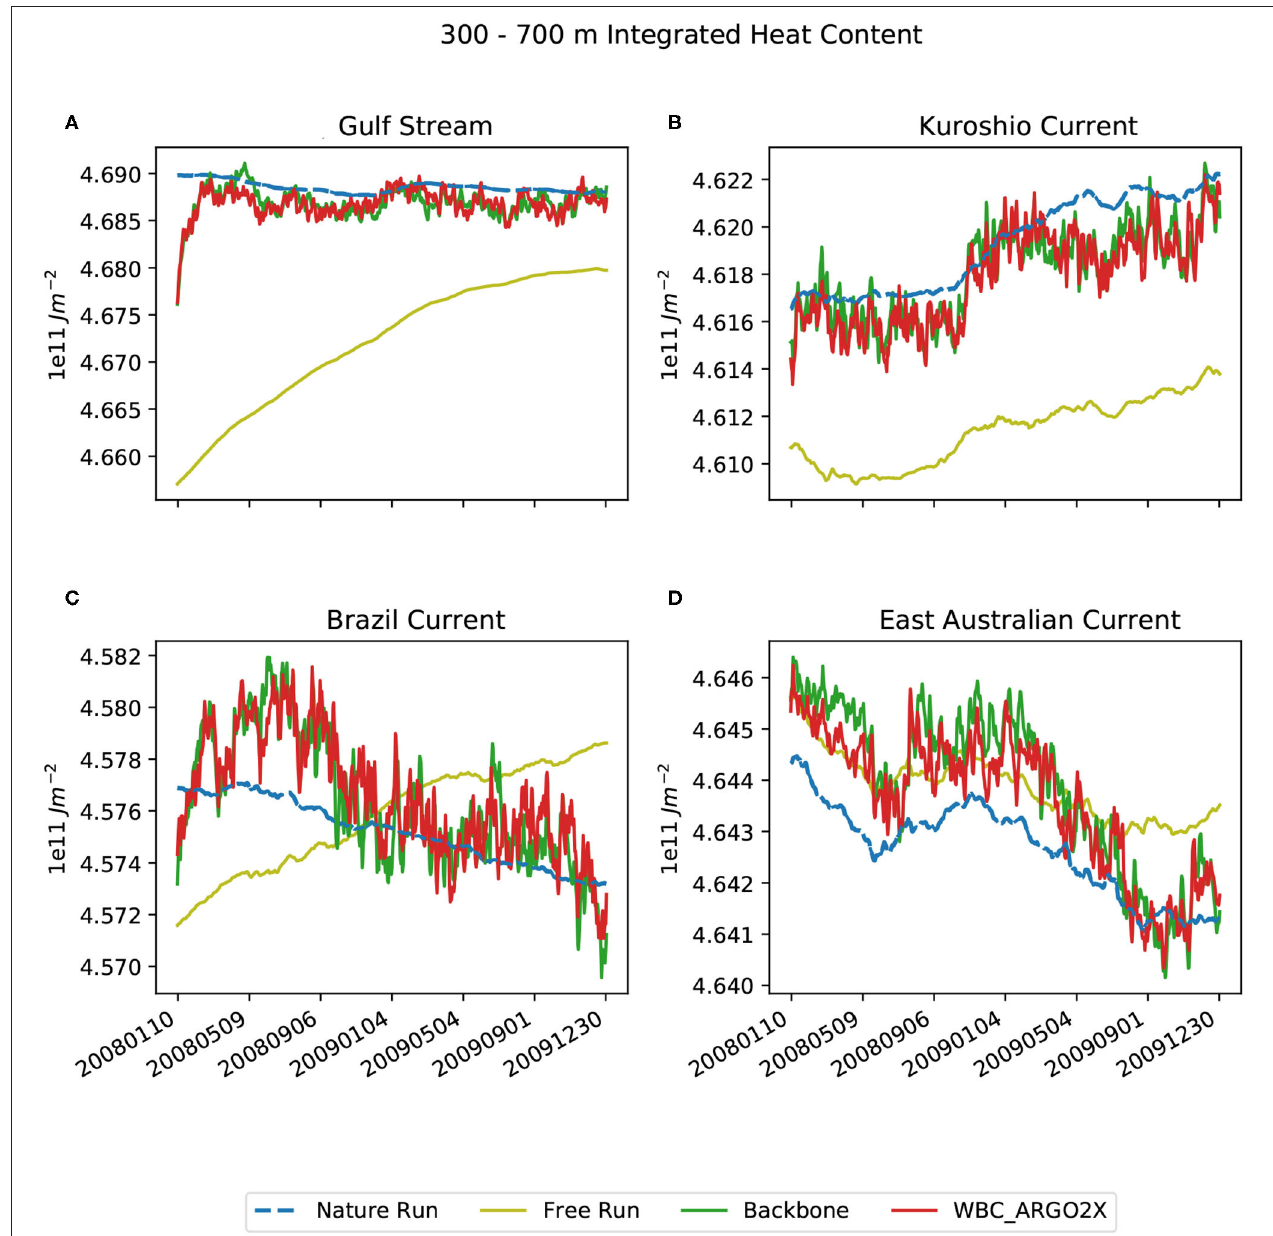
FIGURE 11 | The Ocean Heat Content between 300 and 700m for the Nature Run (dashed blue lines), Free Run (yellow), Backbone (green), and WBC_ARGO2X (red). The results were averaged over the Gulf Stream (A) , Kuroshio Current (B) , Brazil Current (C) , and East Australian Current regions (D) .